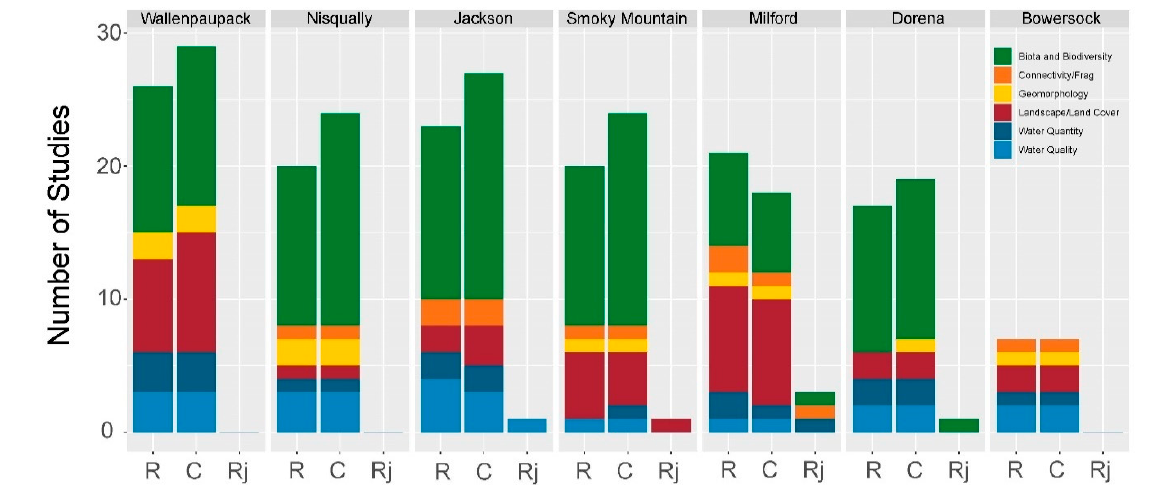
Figure 7. The number of studies by category that were requested (R), completed (C), or rejected (Rj) for each of the seven case study projects in dataset 2.